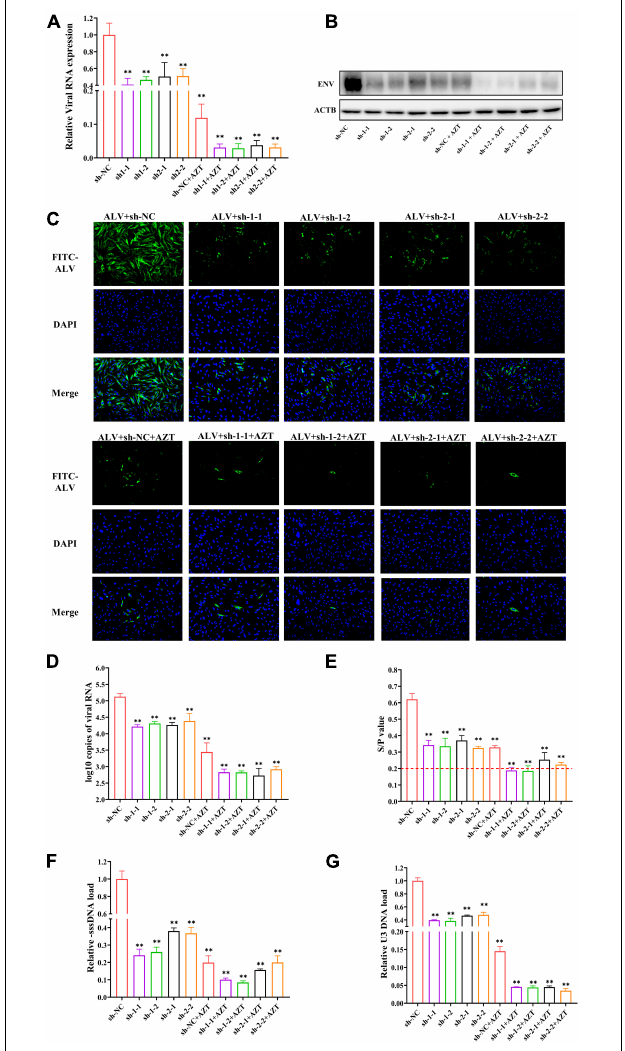
FIGURE 5 | Additive antiviral activity of shRNA and AZT. (A) Quantitative analysis of relative ALV RNA expression in DF-1 cells. The viral RNA levels were determined by real-time PCR and normalized to β -actin . (B) Western blot analysis of ALV-J ENV and β -actin in DF-1 cells. The expression levels of the envelope protein of ALV-J were normalized against β -actin. (C) Immunofluorescence detection of ALV-J in DF-1 cells. The expression of envelope protein of ALV-J was observed under a fluorescence microscope (magnification, × 200). Bright green indicates the presence of ALV-J–positive cell, and blue represents nuclei. (D) ALV-J loads in culture supernatant. The copies of ALV-J RNA were detected by real-time PCR and normalized to per 100 µ l of culture supernatant. (E) p27 antigen levels of ALV-J were detected by ELISA. The red dotted line indicates the cut-off value (S/P = 0.2) of the positive criteria. (F,G) Quantitative analysis of the synthesis or transfer of the minus strand DNA of ALV-J in DF-1 cells. The pro-viral DNA levels were determined by real-time PCR and normalized to HMG-14b . ∗∗ P < 0.01 and ns represents not statistically significant. All experiments were repeated three times. The error bars represent the